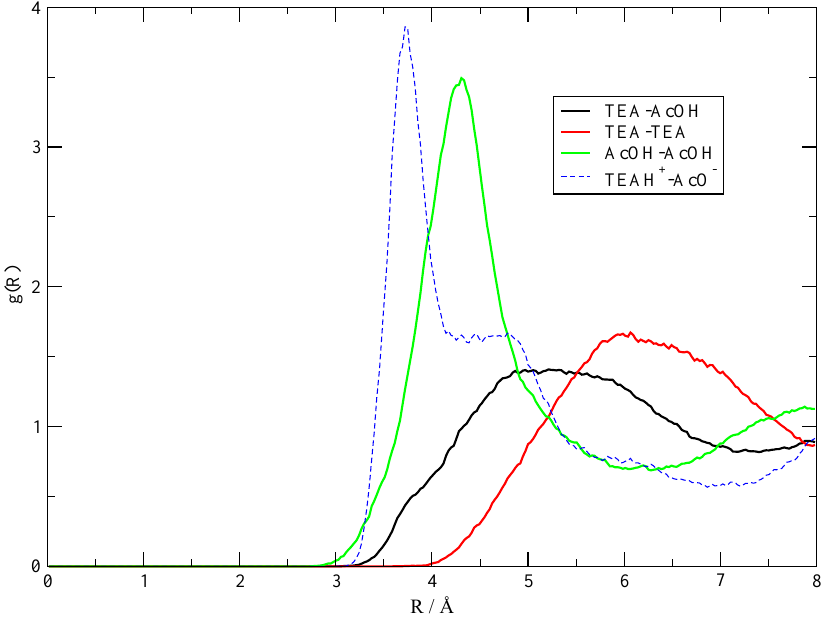
Figure 3. Solid lines: center-of-mass radial distribution functions between the components of the fluid regardless of their charge status as obtained from the 20:20 simulation. The dashed line was obtained from the I20:20 system to show where the pair distribution would peak in a highly ionized system.